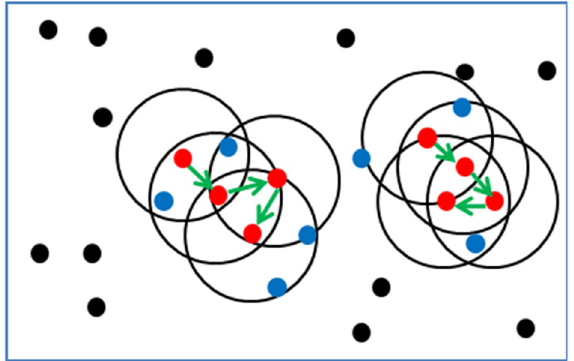
Figure 3. DBSCAN clustering